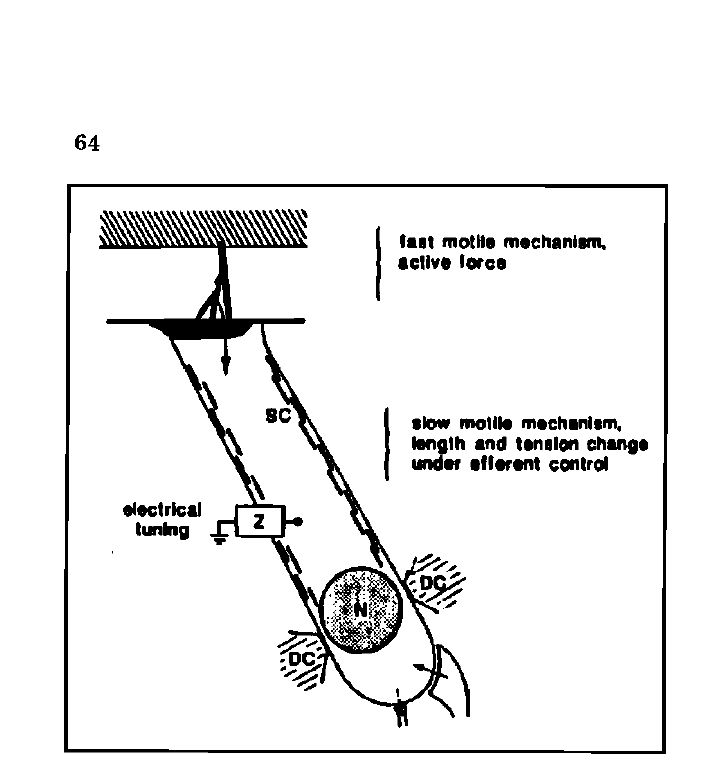
Figure 4. Schematic diagram of an outer hair cell illustrating proposed origins of the fast and slow motile responses and the apical areas rich in subcisternae (SC) (after Kim, 1986, p. 110).